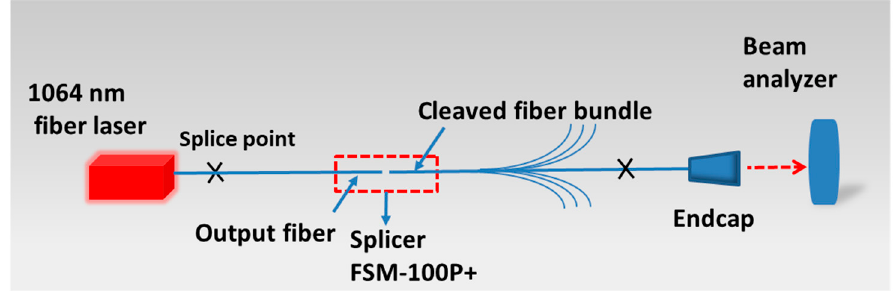
Figure 4. M 2 -based in-line alignment splicing structure.